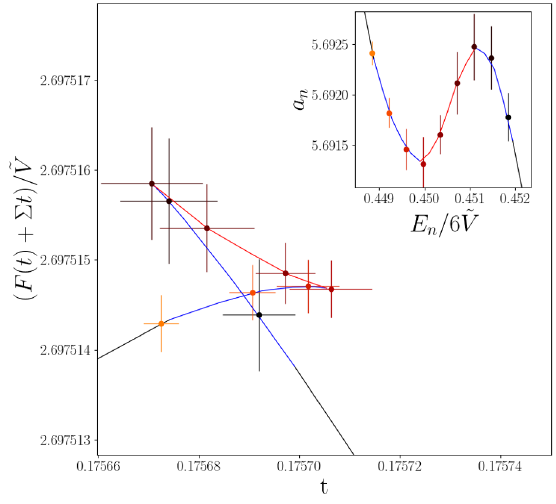
Figure 4. The free-energy for SU(3) Yang-Mills gauge theory on a 4 × 20